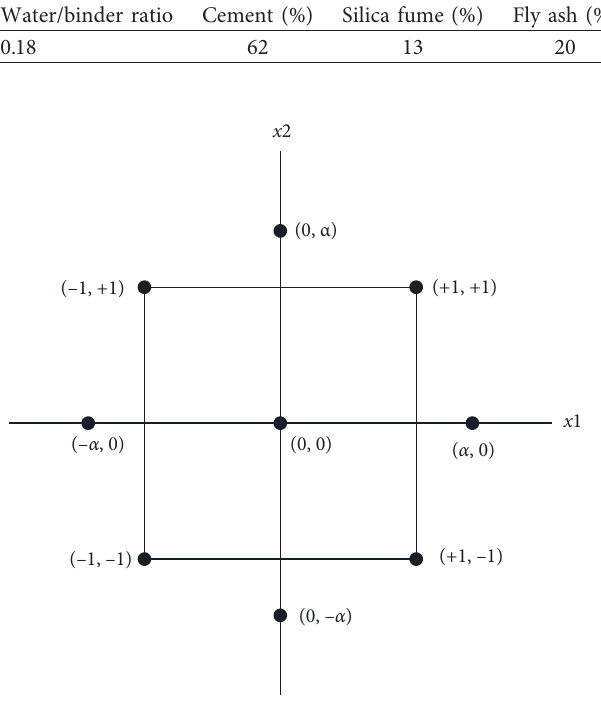
Figure 6: Two-factor CCD.